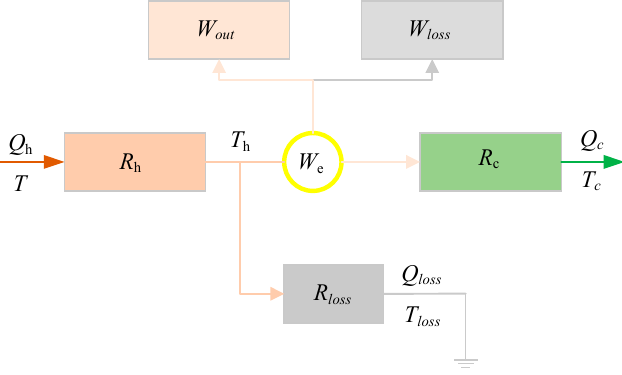
Figure 7. Schematic of Stirling conversion thermal resistance model.